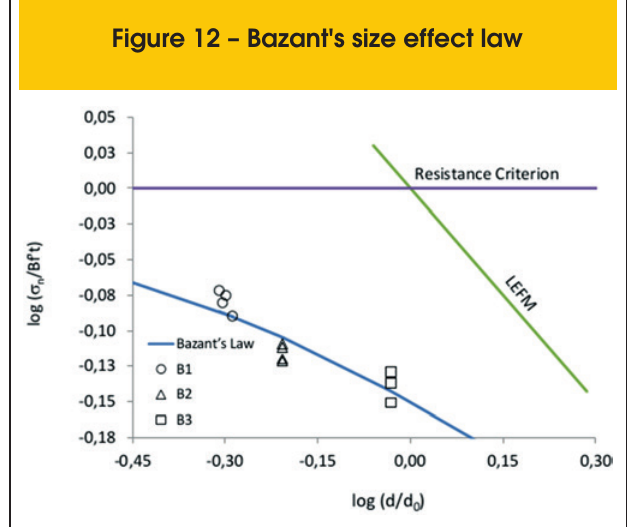
Table 4 – Ultimate tensile strength and fracture parameters